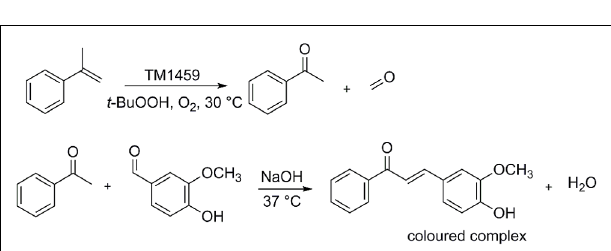
FIGURE 2 | Biocatalytic oxidative alkene cleavage of α -methylstyrene and formation of aldol condensation product between acetophenone and